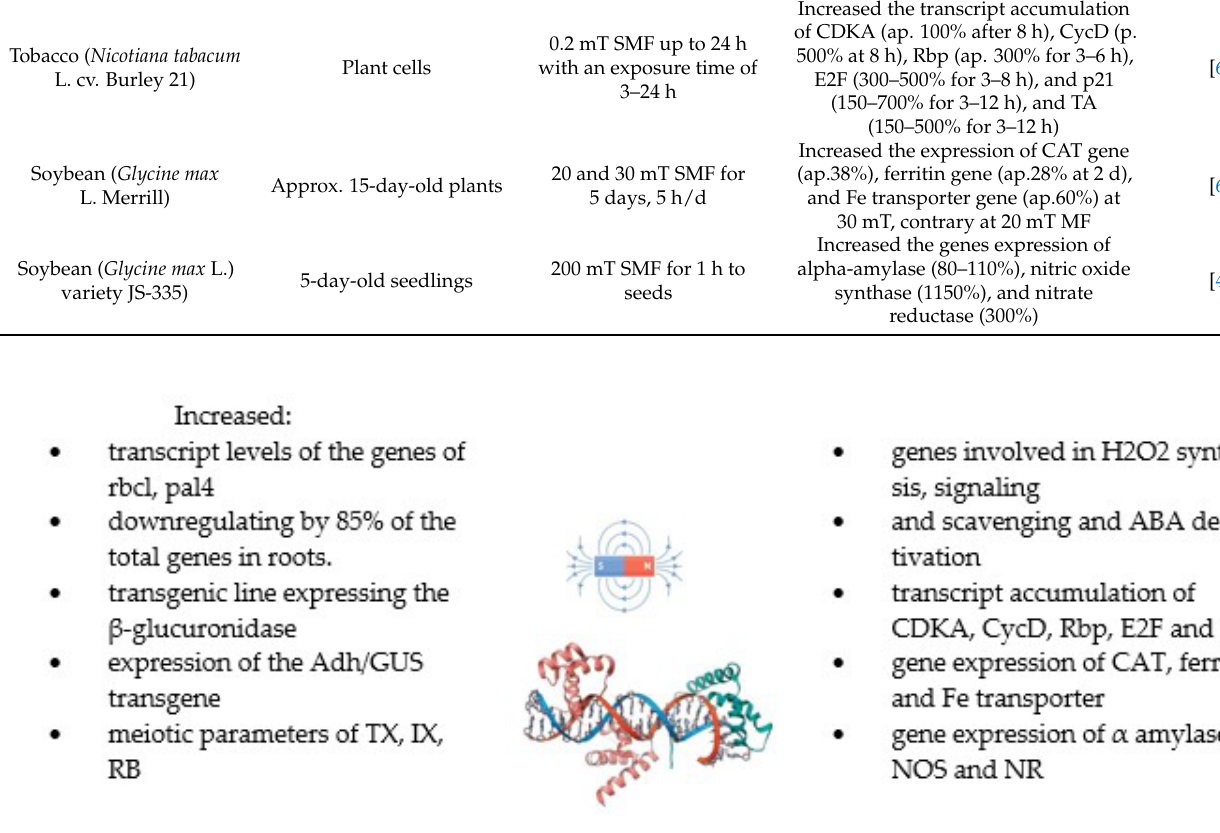
Figure 5. The summary of the effects of MFs on gene expression